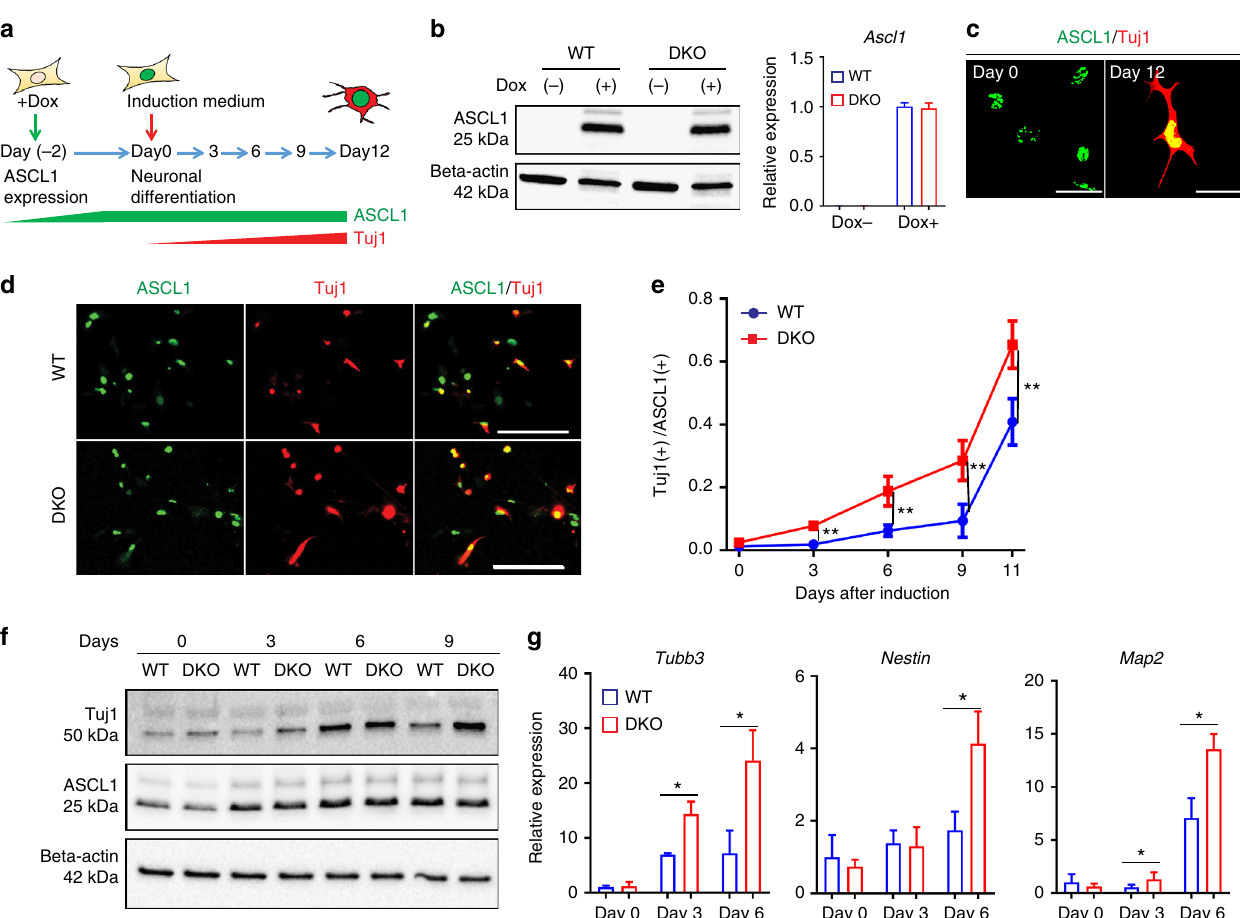
Fig. 6 HMGN depletion enhances direction lineage conversion of MEFs to induced neurons. a Protocol for direct lineage conversion of MEFs to induced neurons by transcription factor ASCL1. b Western blot (left) and qPCR gene expression analysis (right, 3 biological replicates, scale bar: mean ± SD) showing equal expression levels of ASCL1 in WT and DKO MEFs two days after doxycycline induction. For qPCR gene expression analysis, average of three biological replicates is shown and bar graph represents mean ± SD. c Immuno fl uorescence staining of ASCL1 and TUJI in MEFs at day 0 and day 12 of doxycycline induction. Scale bar: 50 μ m. d Immuno fl uorescence staining of ASCL1 and TUJI in WT and DKO cells after 12 days of differentiation induction. Scale bar: 200 μ m. e Quantitative analysis of neuronal induction ef fi ciency in WT and DKO MEFs by counting the number of TUJ1 positive cells relative to the number of ASCL1 positive cells at different induction time points (average of three biological replicates is shown, mean ± SD). f Western blot analysis of TUJ1 expression in WT and DKO MEFs at different induction time points. g Enhanced expression levels of neuron-speci fi c markers, Tubb3 , Nestin and Map2 markers in transdifferentiated DKO MEFs. Gene expression level at each time point was normalized to Gapdh expression level (Average of three biological replicates are shown, mean ± SD). T-test was used in e , g . p values: * p < 0.05; ** p <